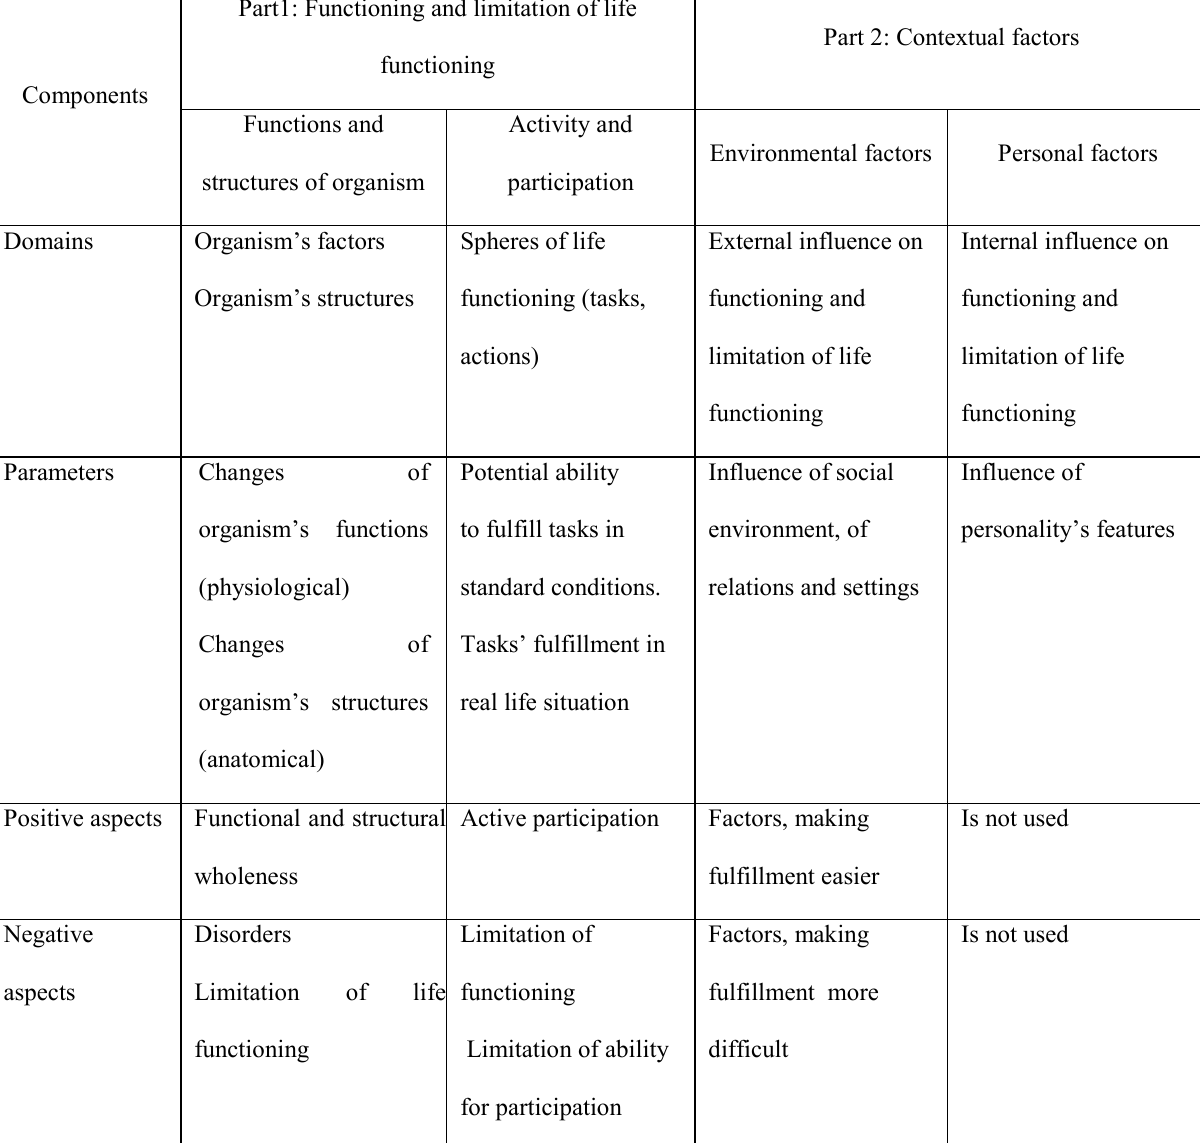
International classification of functioning, limitations of life functioning and health